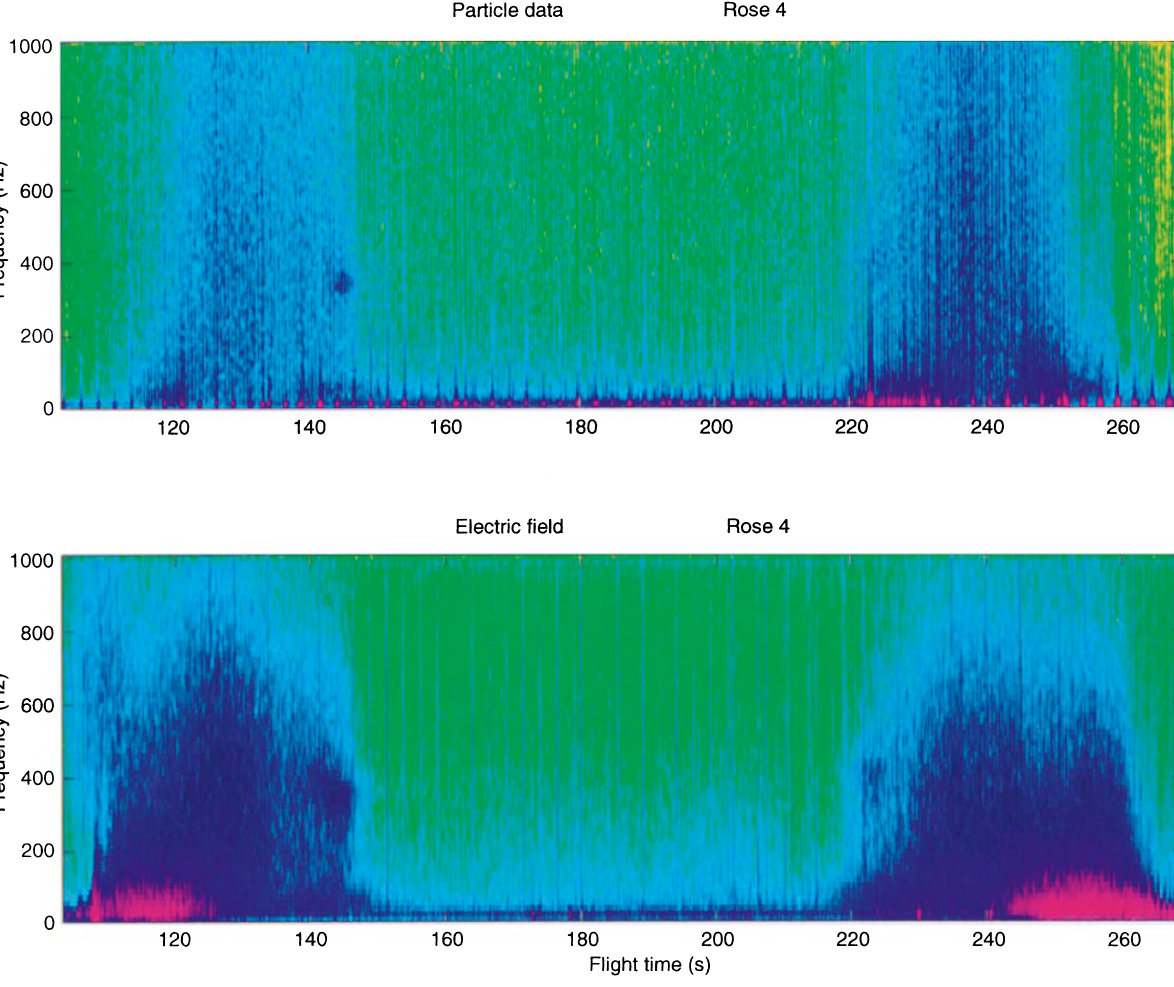
Fig. 5. Spectral distributions of the electroject fluctuations as a function of time after launch. See Fig. 4 for the corresponding altitudes. The top frame shows fluctuations in plasma density (‘‘particle data’’) obtained by the current to a retarding potential analyzer on the rocket (Rose et al ., 1992). The lower frame is obtained